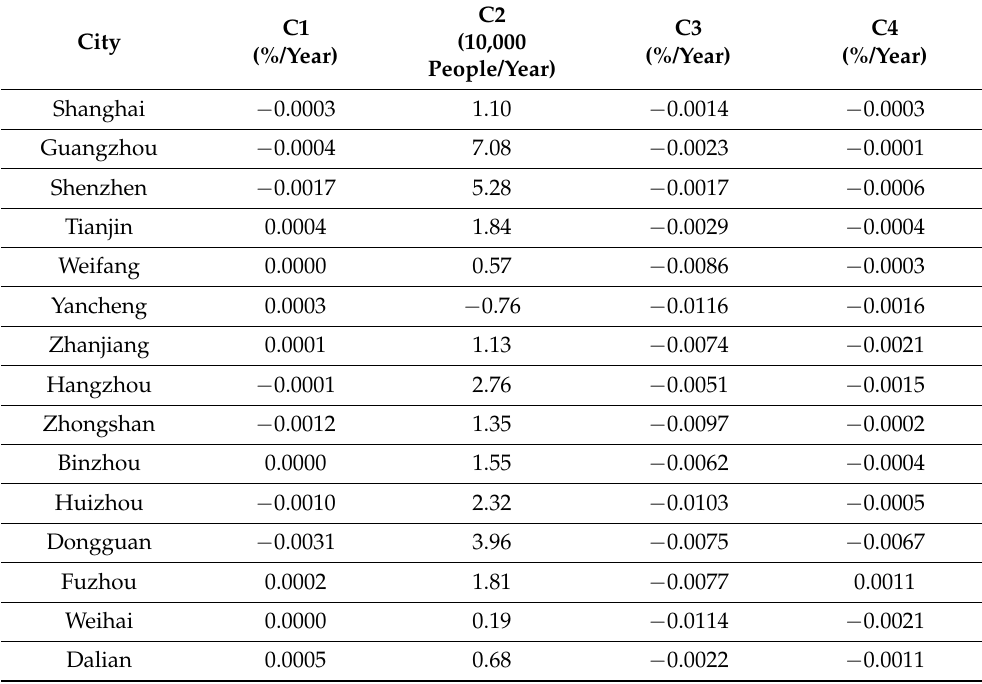
Table A2. Annual mean change rate of sensitivity indicators in 15 coastal cities from 1990 to